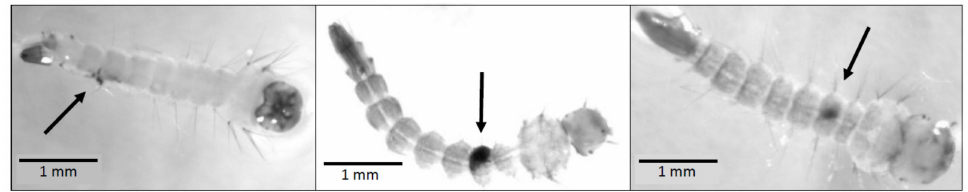
Figure 2. Evidence of melanisation in focal larvae that died in the presence of a copepod predator on the eighth, ninth, and tenth days of observation,